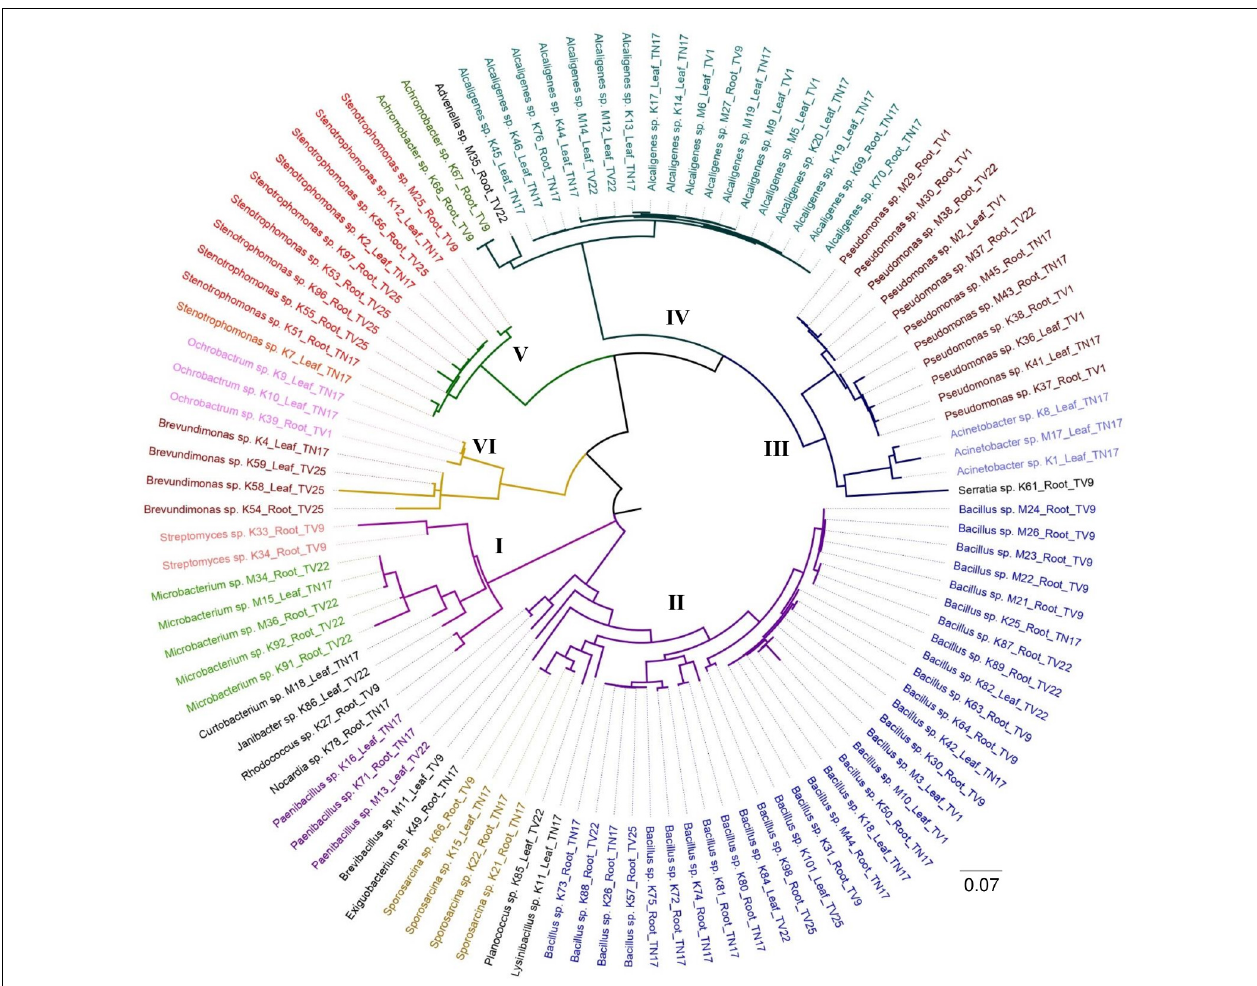
FIGURE 2 | The maximum likelihood phylogenetic tree of endophytic bacterial isolates obtained from five different tea clones based on 16S rRNA gene sequences; the scale bar represents the distance from the origin to the most distant taxa. Clades that are distinctly clustered are represented by six different